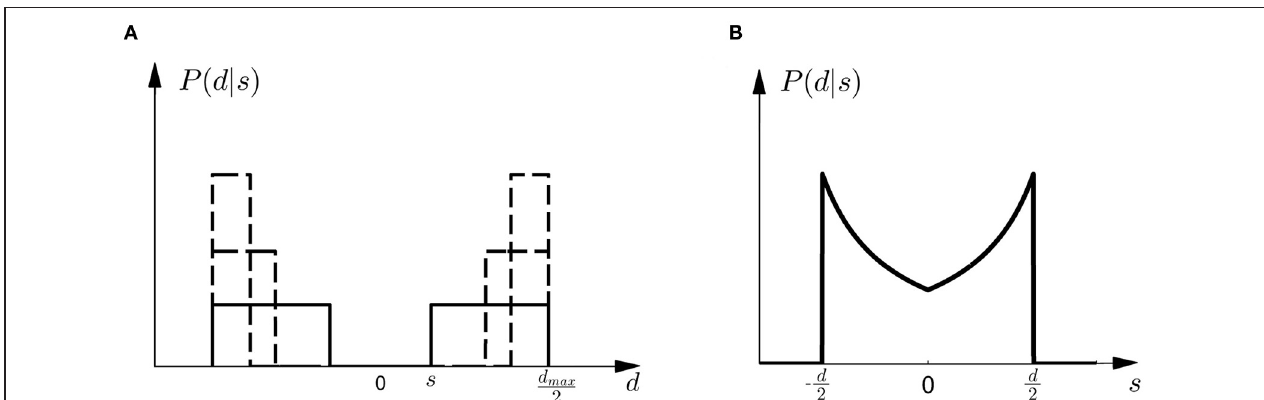
FIGURE 4 | Observation model. (A) Shows the probability P ( d | s ) of observing an array of width d given the shift s . All array widths up to a maximum d max have equal probabilities but arrays that are too small to contain the shift s have zero probability. The figure shows three different cases for three different shifts s with a solid line and two dashed lines, respectively. It is important to notice that in